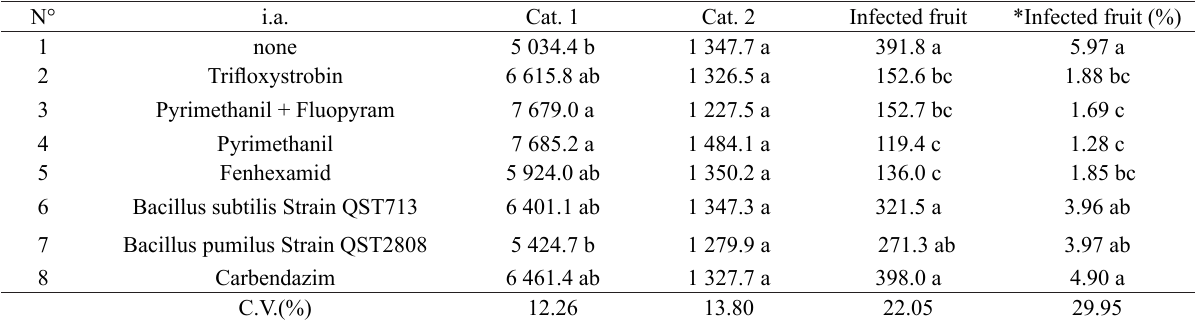
Table 3. Effect of chemical and biological fungicides on strawberry cv. Aromas Yield under field conditions.